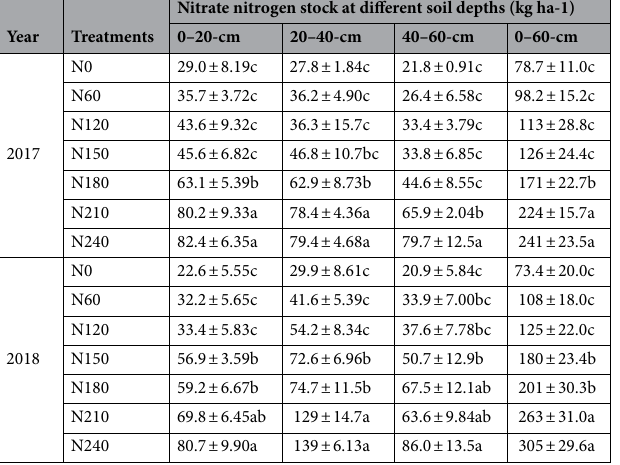
Table 2. Nitrate nitrogen stock at different soil depths in treatments with different nitrogen fertilizer rates. Different letters at the same soil depth indicate significant differences (P < 0.05) among treatments in the same year.